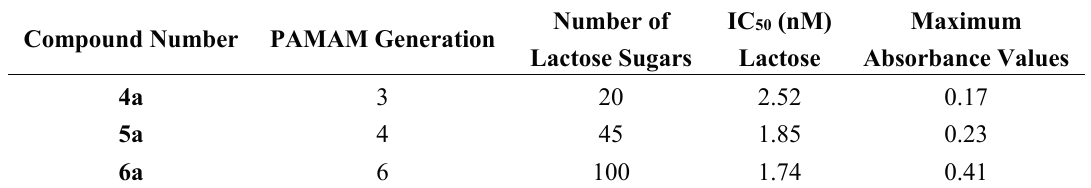
Table 3. Results for Compounds 4a , 5a , and 6a with